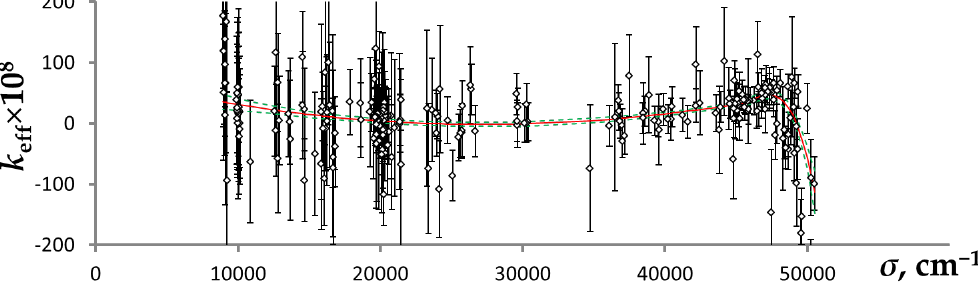
Figure 2. Dependence of calibration factor for interferometric measurements of Ross [2] on wavenumber. The error bars are measurement uncertainties of Ross [2] and our FTS data, combined in quadrature. The solid line is a weighted fit with two cubic polynomials stitched together at about 45000 cm −1 . The dashed lines are 68% confidence intervals (±1 standard deviation) of the fit. It should be noted that Figure 2 includes all Ross’s lines that were also measured in our FTS spectra. Many of those lines were weak in our FTS spectra, resulting in large error bars in Figure 2.